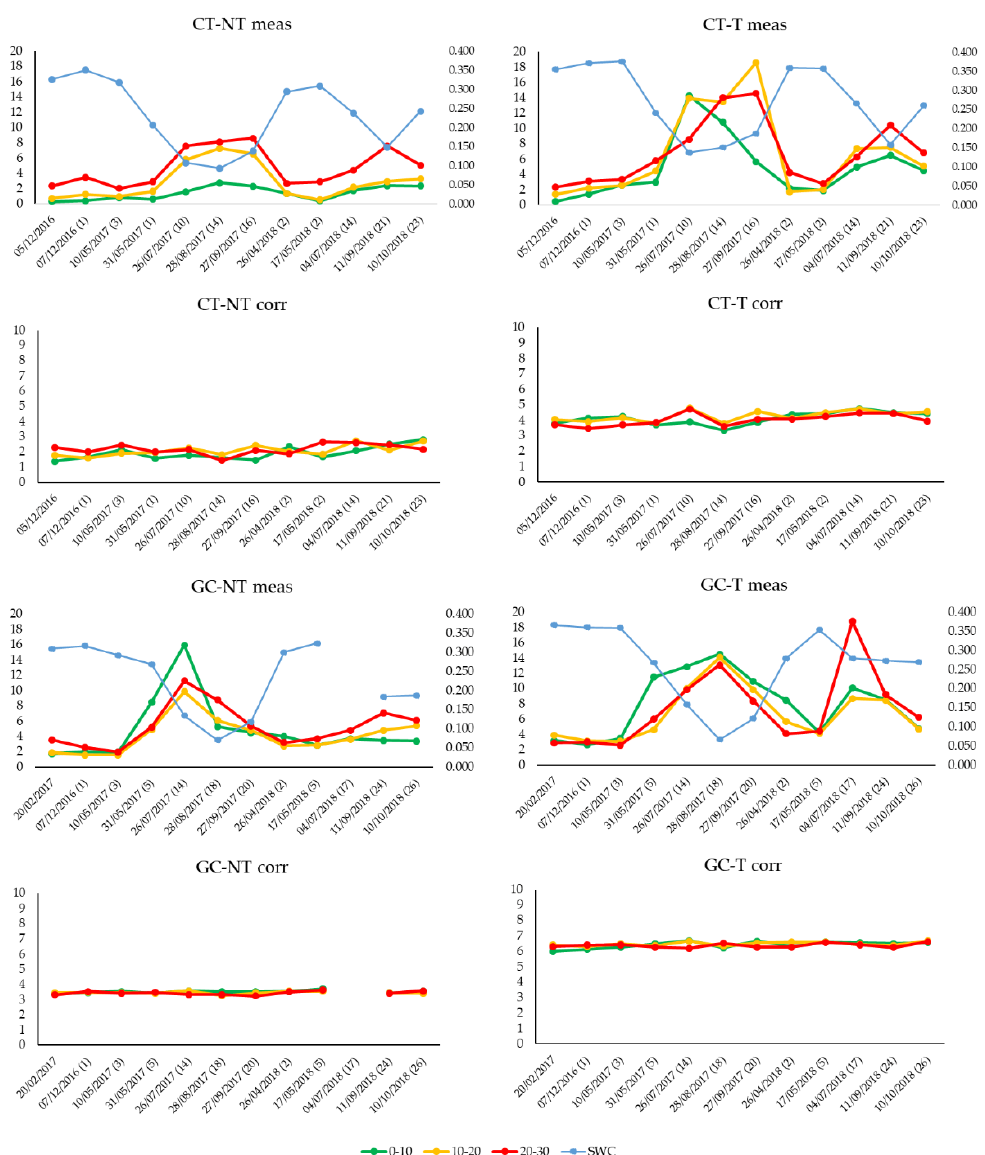
Figure 5. Values of soil penetration resistance (PR) in different positions of each treatment, for depth intervals 0 – 10, 10 – 20, and 20 – 30 cm, with corresponding mean SWC, and values of corresponding normalized penetration resistance, corrected for value set at SWCcorr = 0.300 m 3 m − 3 .